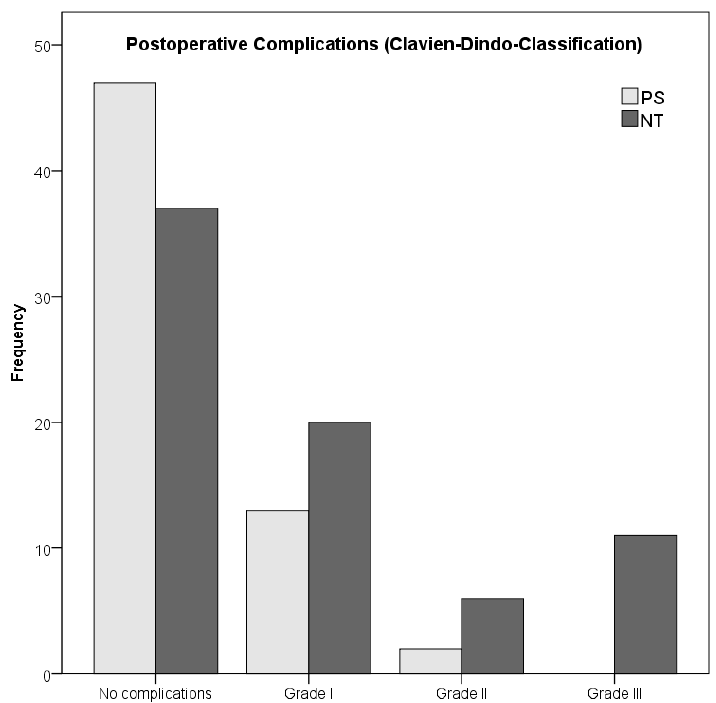
Figure 6. Development of postoperative complications with and without NT.